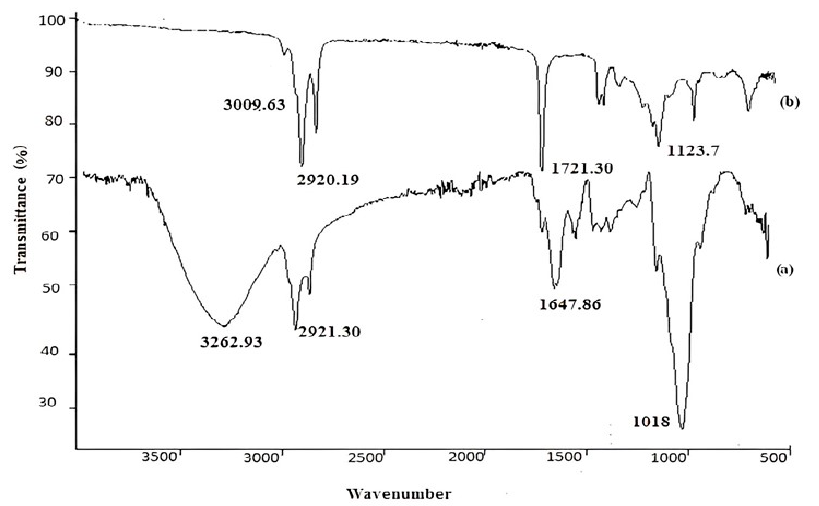
Figure 1. FTIR spectra of unloaded ( a ) and Hg (II)-loaded ( b ) Phanerochaete chrysosporium -based working electrode.